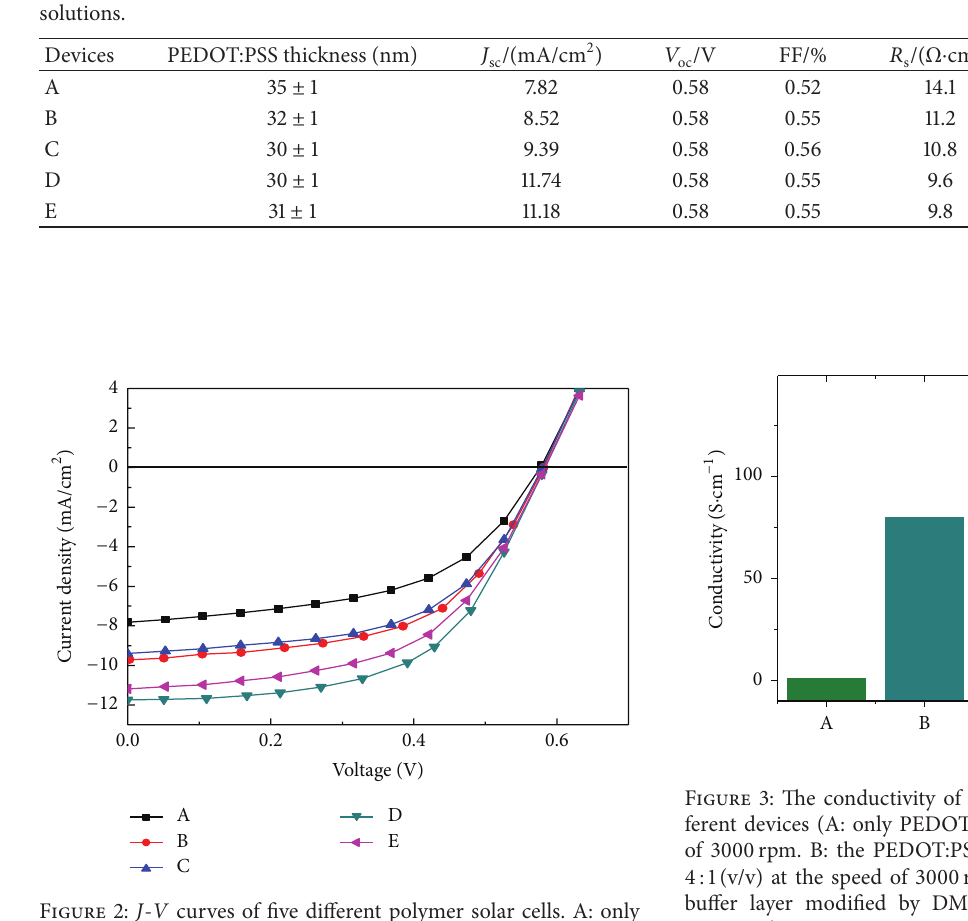
Figure 2: J - V curves of five different polymer solar cells. A: only PEDOT:PSS solution on ITO at the speed of 3000 rpm. B: the PEDOT:PSS and DMAC mixed in a ratio of 4 :1(v/v) at the speed of 3000 rpm. C, D, and E: the PEDOT:PSS buffer layer modified by DMAC at speed of 1000, 3000, and 5000 rpm.